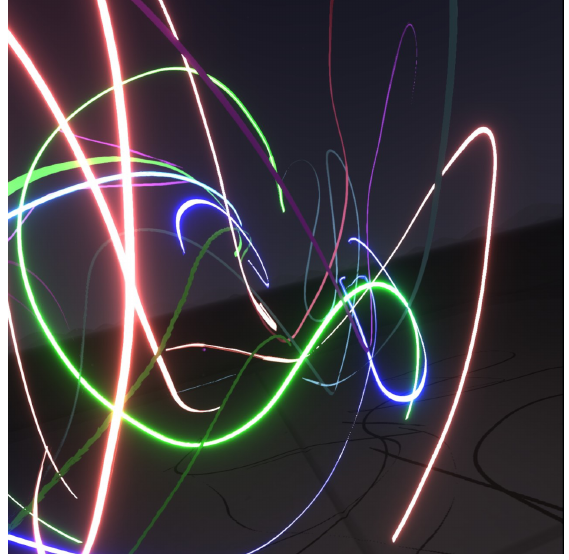
Figure 2. Artwork from virtual art